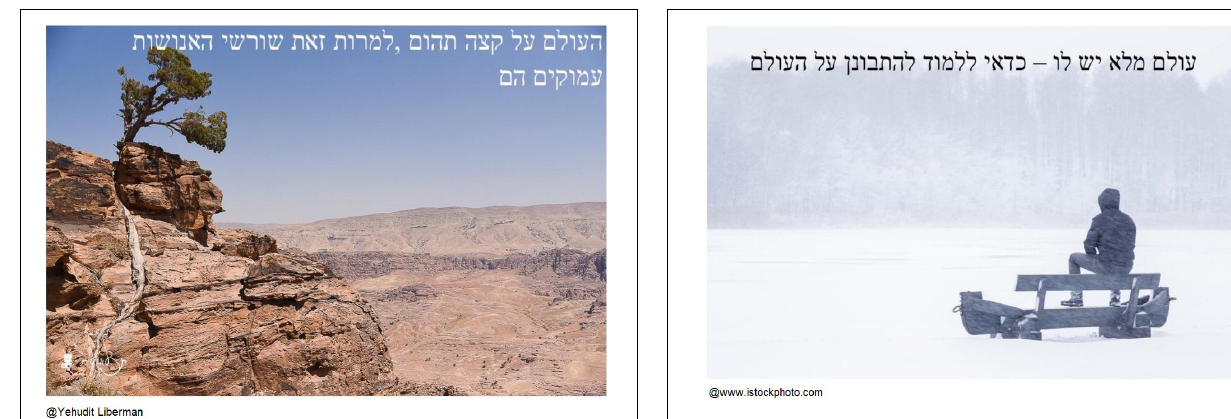
husband discovered their spiritual dimension. She explained how faith helped her to cope when her husband was ill in cancer.